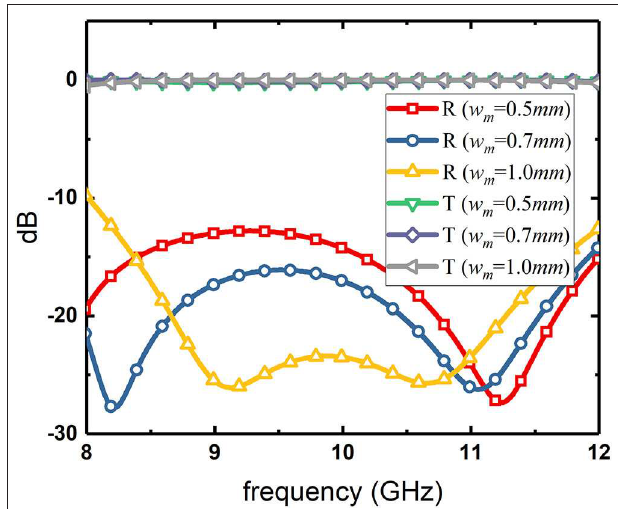
FIGURE 5 | The simulated transmission and reflection spectra of the switchable metasurface when the loaded PIN diodes are off-state. The bandwidth of the transparency can be tuned by the coupling coefficient of the magnetic